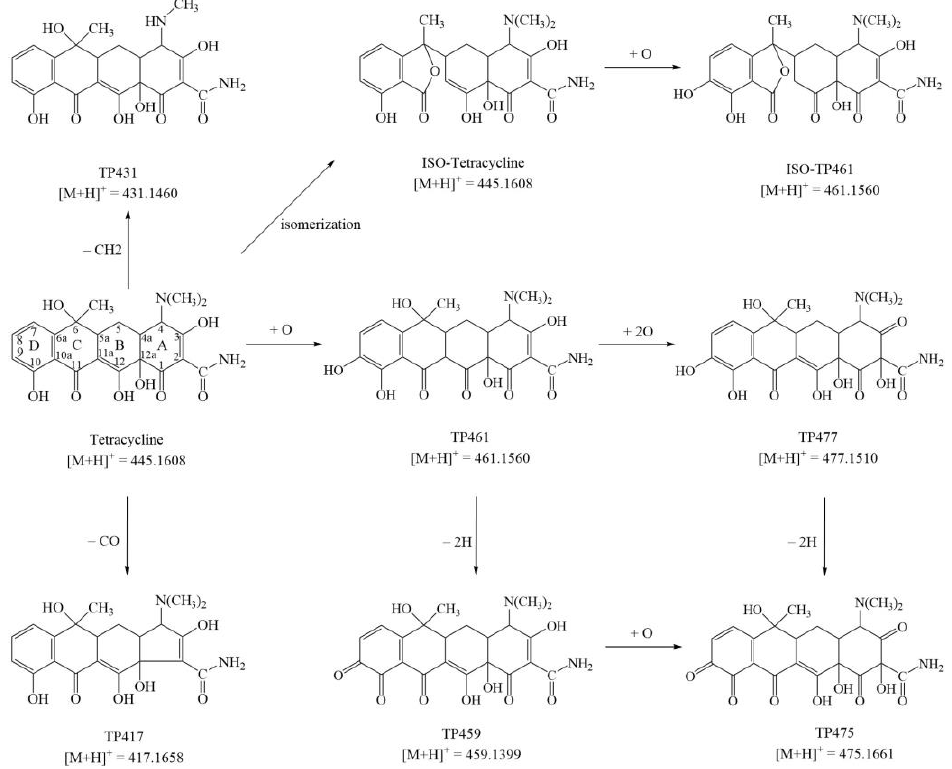
Figure 5. Proposed degradation pathway of tetracycline by the MnP system.